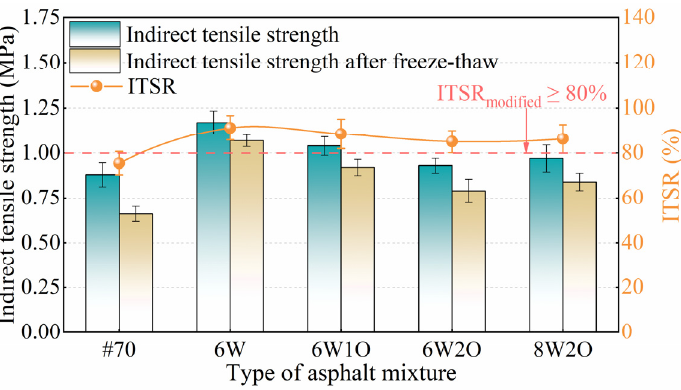
Figure 9. Test results of indirect tensile strength after freeze–thaw.